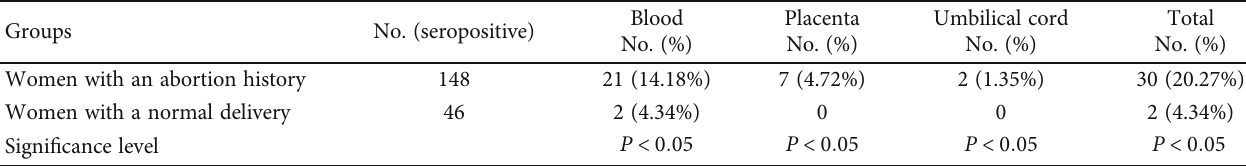
Table 2: The molecular test results of toxoplasmosis in two groups of women with an abortion history and a normal delivery.